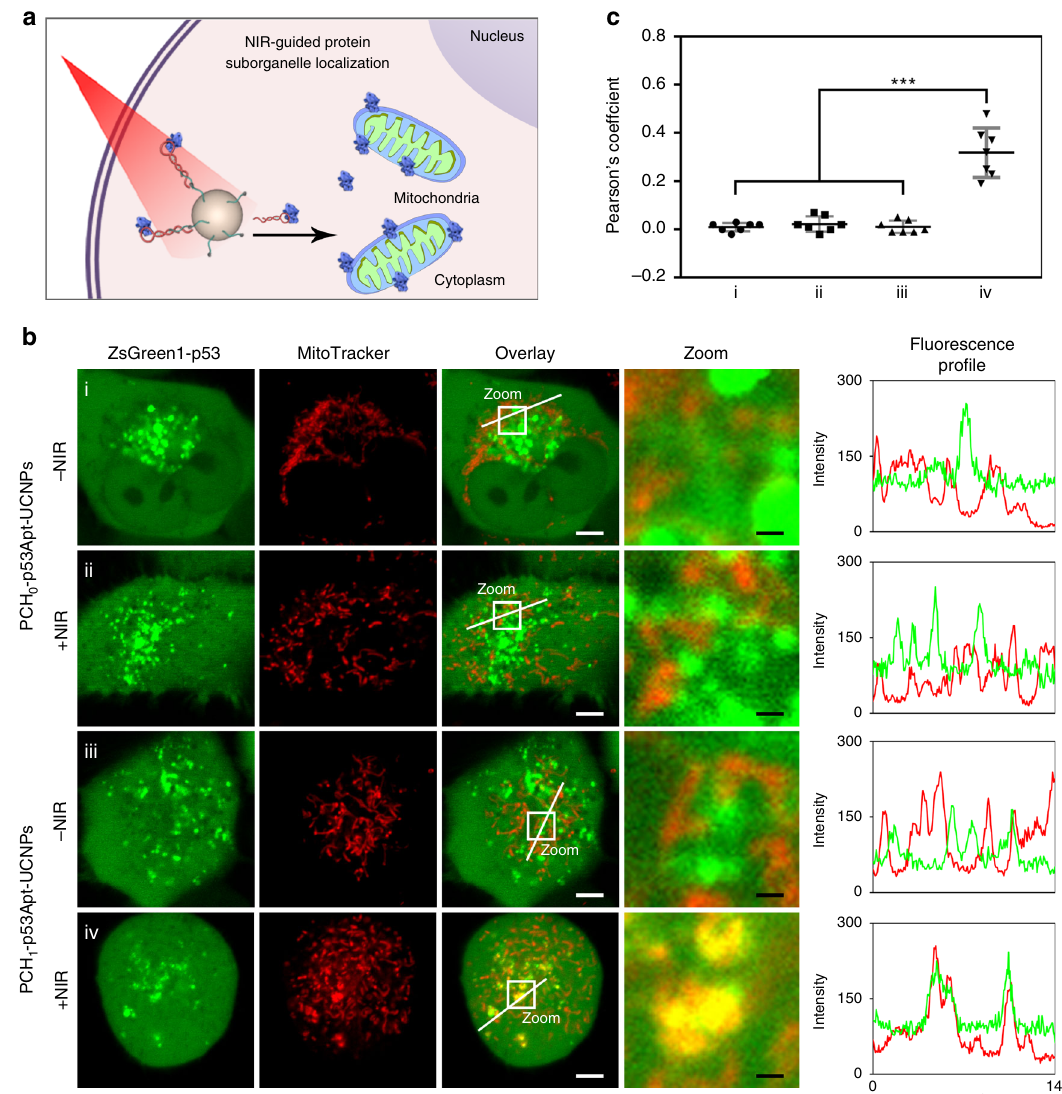
Fig. 6 Manipulation of p53 protein localization in living H1299-ZsGreen1-p53R175H cells with NIR light irradiation. a Schematic illustration of the p53 transportation to mitochondria under NIR light irradiation. b CLSM imaging of living H1299-ZsGreen1-p53R175H cells pretreated with 100 μ g mL − 1 PCH 0 - p53Apt-UCNPs for 3 h and then irradiated with NIR laser for 0 min (i) or 10 min (ii), or pretreated with100 μ g mL − 1 PCH 1 -p53Apt-UCNPs for 3 h and then irradiated with NIR laser for 0 min (iii) or 10 min (iv). From left to right: fl uorescence channel of ZsGreen1-p53, fl uorescence channel of MitoTracker, overlay images, enlarged view of the zoom area in images, and the fl uorescence pro fi ling of ZsGreen1-p53/aptamer (green line) and MitoTracker (red line) in corresponding overlay images. Scale bars in overlay images and zoom images represent 5 μ m and 0.65 μ m, respectively. c Co-localization analysis of p53R175H/aptamer with mitochondria based on the corresponding seven CLSM images in ( b ). Seven images of co-localization analysis come from three independent experiments. The Pearson ’ s coef fi cient was calculated with an Image J software. Error bars represent the standard deviation of the Pearson ’ s coef fi cient data. Data are presented as mean values± S.D. *** P = 0.0000045 (i), 0.0000096 (ii) and 0.0000055 (iii) ≤ 0.001, by two-tailed unpaired Student ’ s t